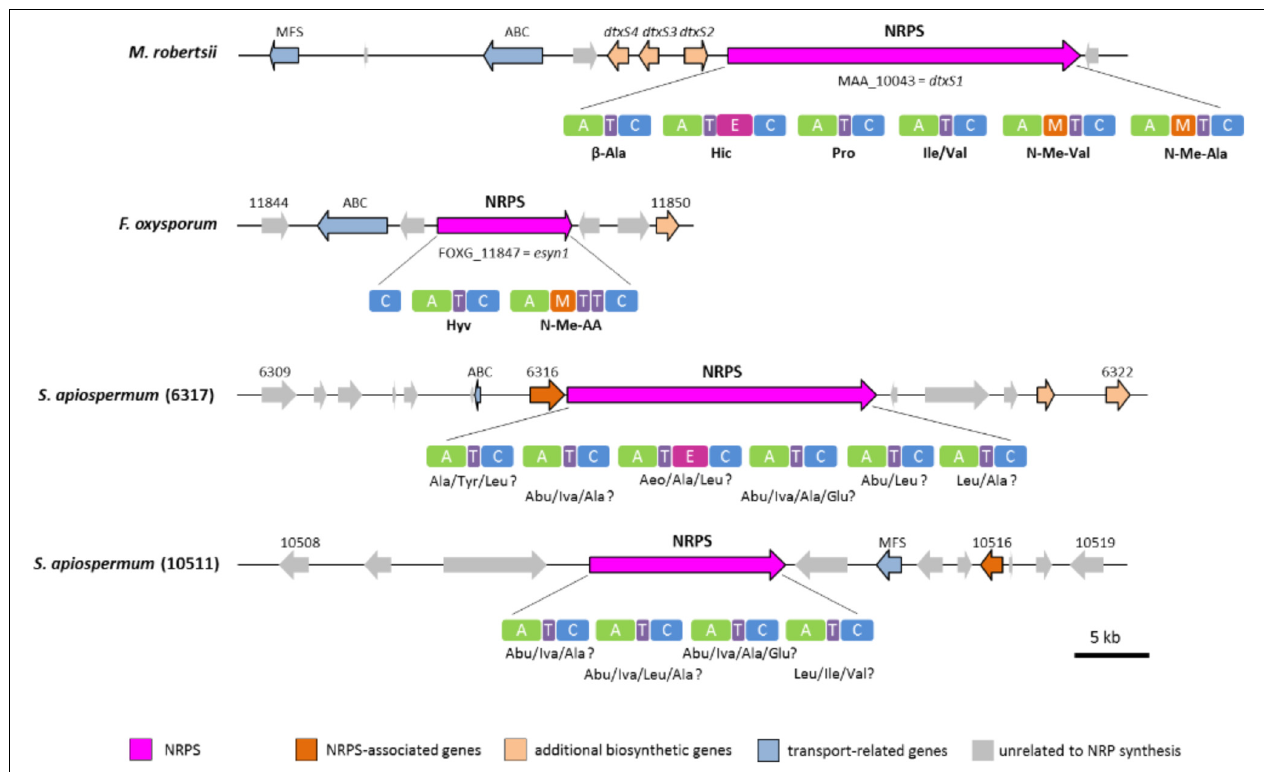
FIGURE 6 | Genomic organization and modular domain structure with A-domain specificities of cyclopeptide-synthesizing NRPSs. Abbreviations for unusual hydroxyl and amino acid substrates: Abu, 2-amino-butyric acid; Aeo, 2-amino-9,10-epoxy-8-oxodecanoic acid; Hic, D -2-hydroxyisocaproic acid; Hyv, D -2-hydroxyvaleric acid; Iva,